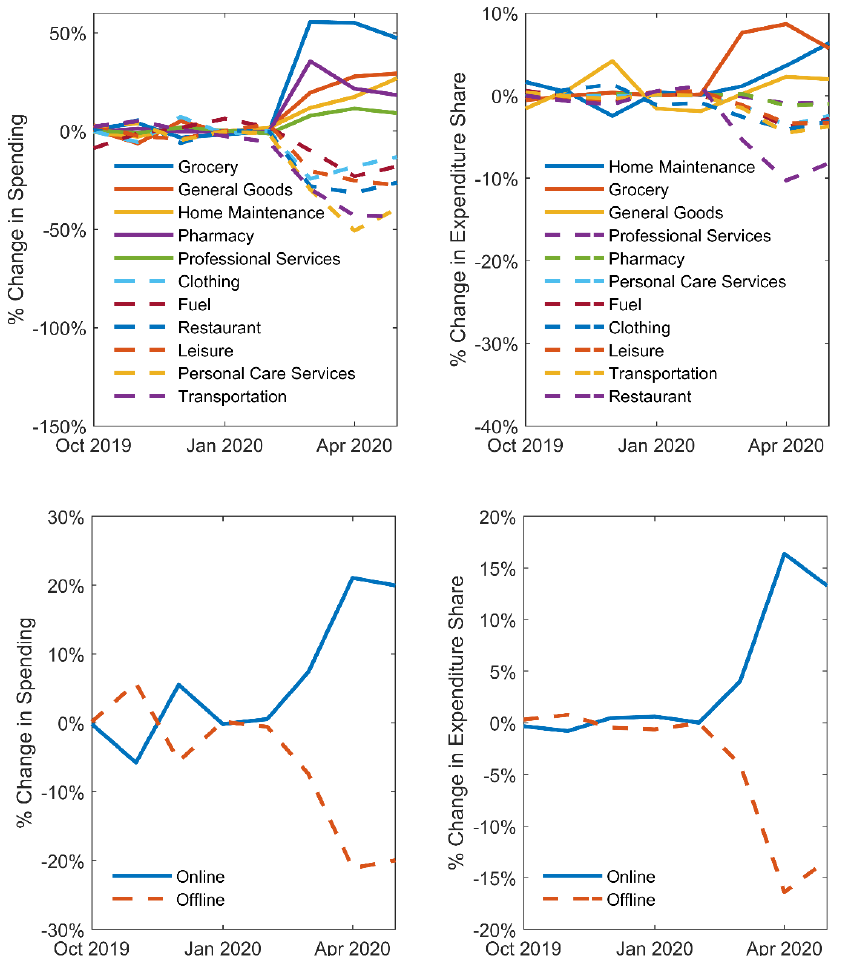
Figure 1. Spending and Expenditure Shares with Equal Pre-COVID-19 Values. Source: Author calculations. Note: Series in percentage changes represent the estimated values of sector-time fixed effects or shopping channel-time fixed effects that have been normalized by their average values between October 2019 and February 2020.